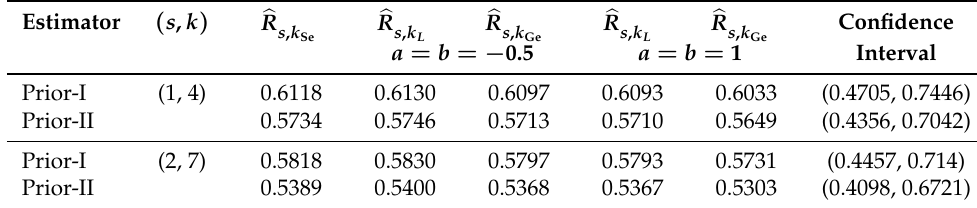
Table 12. The result of Bayesian estimation for strength data.